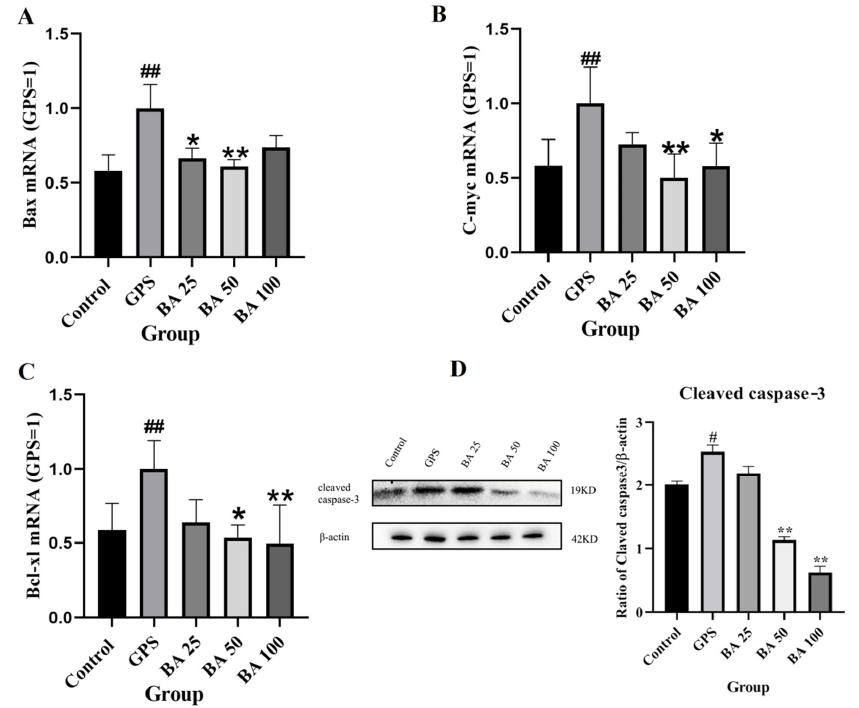
Figure 2. Effects of baicalin on gene expression of Bax ( A ), C-myc ( B) , Bcl-xl ( C ), and protein expres- sion of cleaved caspase-3 ( D ) in PPMC induced by GPS. GPS: G. parasuis group, BA 25: 25 mg/kg baicalin + G. parasuis group, BA 50: 50 mg/kg baicalin + G. parasuis group, BA 100: 100 mg/kg baicalin + G. parasuis group. #,## p < 0.01 vs control. * p < 0.05 vs G. parasuis group, and ** p < 0.01 vs G. parasuis group.